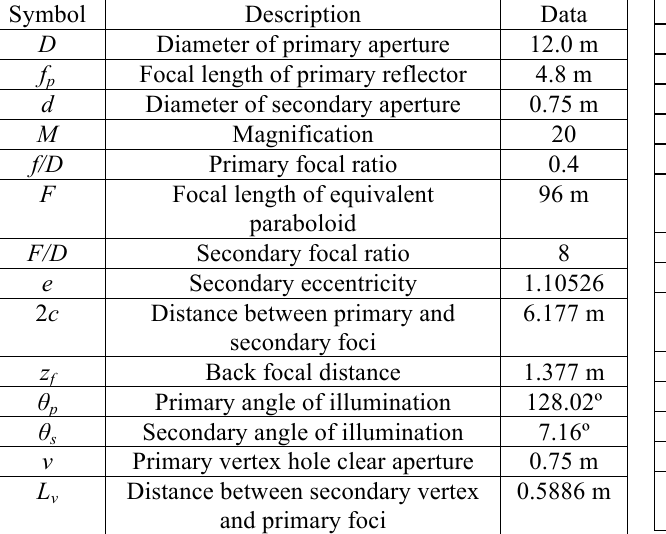
Table 2: Parameters for the on-axis Cassegrain antenna.